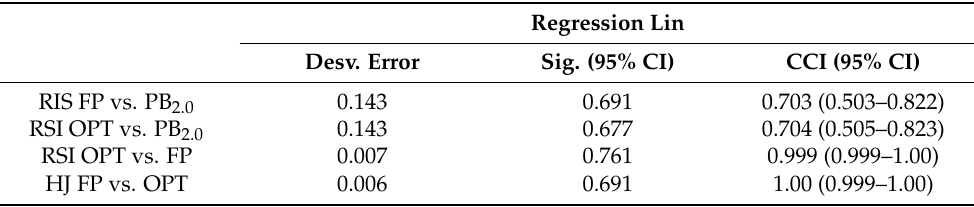
Figure 4. Agreement between the used methods. ( a ) intraclass correlation coefficient of RSI between PB2.0 and FP; ( b ) intraclass correlation coefficient of RSI between PB2.0 and OPT; ( c ) intraclass correlation coefficient of RSI between FP and OPT; ( d ) intraclass correlation coefficient of HJ between PB2.0 and OPT. Table 3. Concurrent validation of linear regression and ICC between measuring devices during